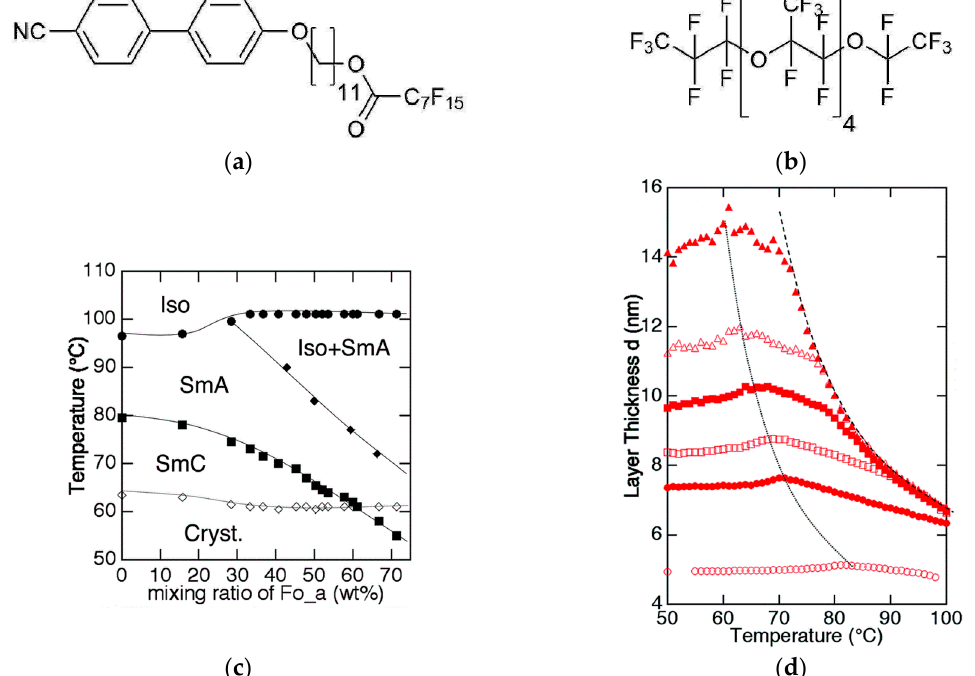
Figure 8. ( a ) Chemical structure of the mesogenic perflourinated cyano biphenyl. ( b ) Examples of one of the perflourinated solvents used, ( c ) the corresponding phase diagram and ( d ) the temperature-dependent layer spacing d ( T ). The mesogen to solvent ration in ( d ) gradually changes from 1:2 (filled triangles) to 2:1 (filled circles). The layer spacing of the neat mesogen in depicted with open circles. (Reprinted by permission from RCS Publishing: [24].)